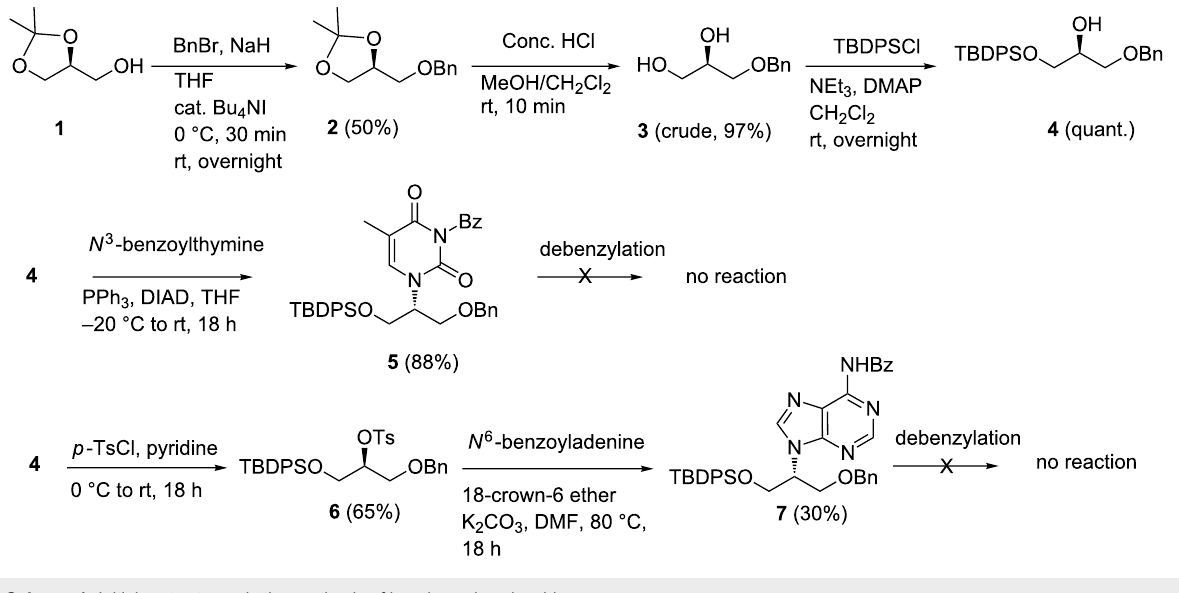
Scheme 1: Initial routes towards the synthesis of iso-glycerol